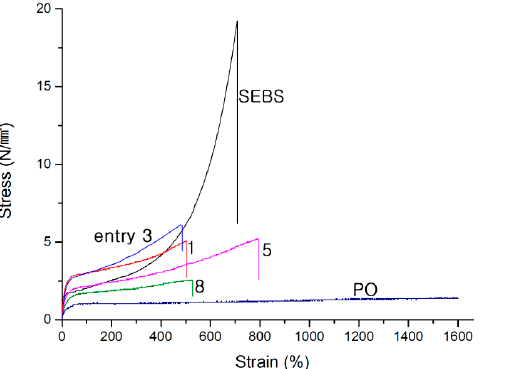
Figure 4. Tensile stress-strain curves for the prepared block copolymers (entries 1, 3, 5, and 8, Table 2), poly(ethylene- co -propylene), and SEBS.